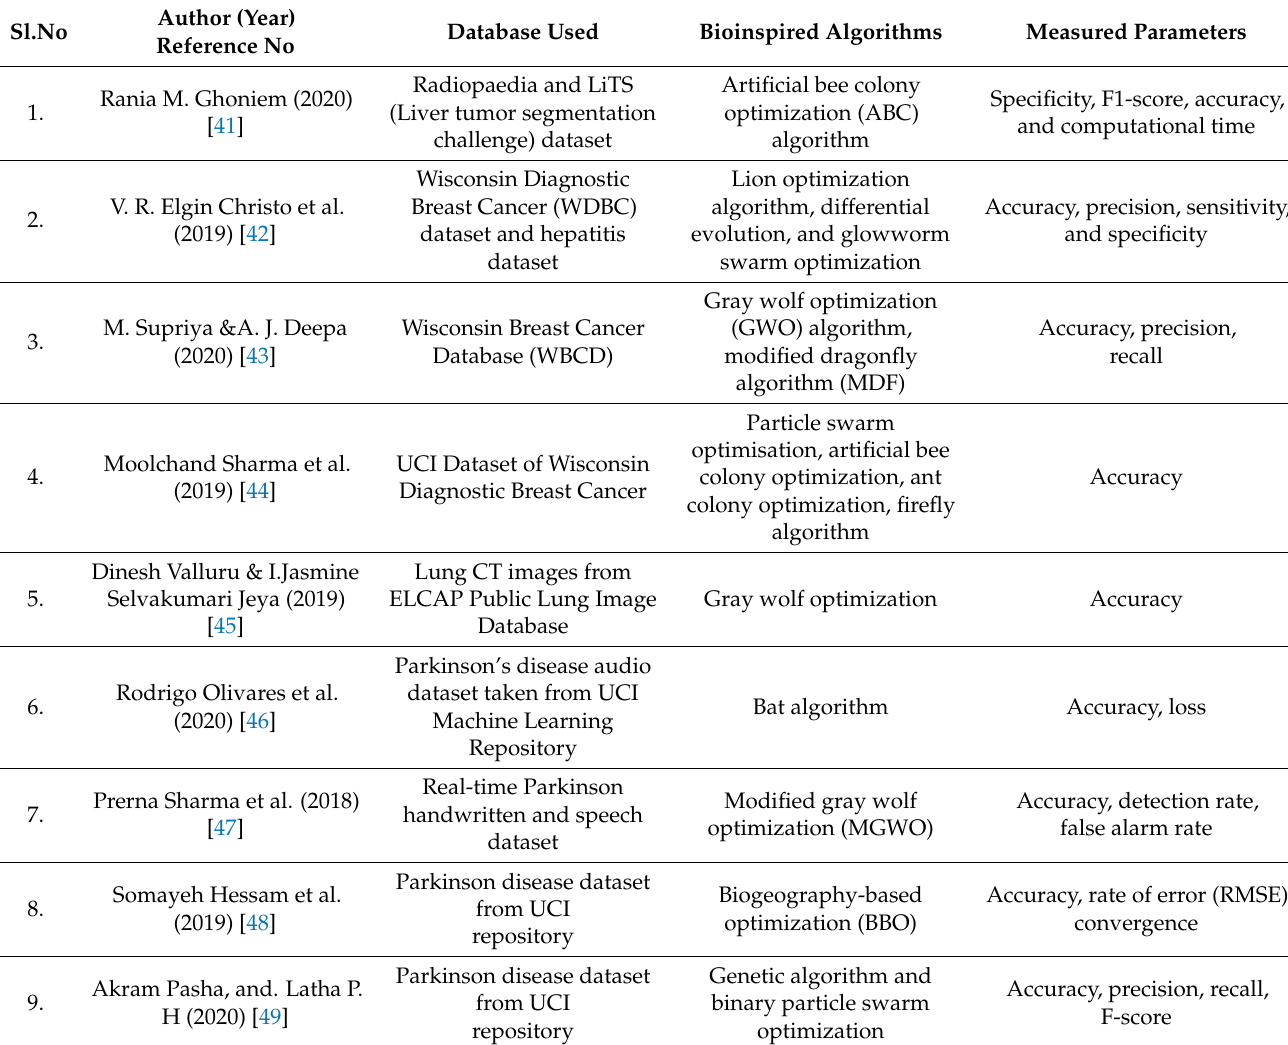
Table 4. List of some important disease prediction models based on bioinspired